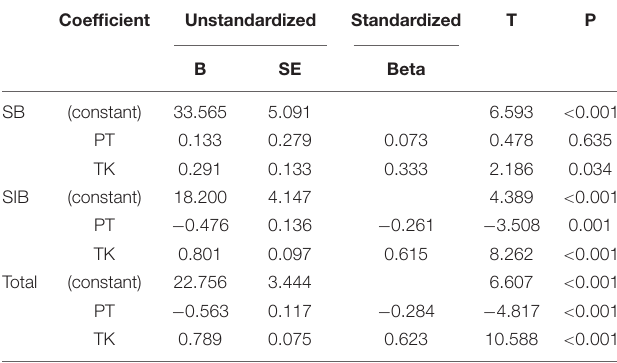
TABLE 4 | Multiple linear regression analysis on LL in matched and unmatched groups. Coefficient